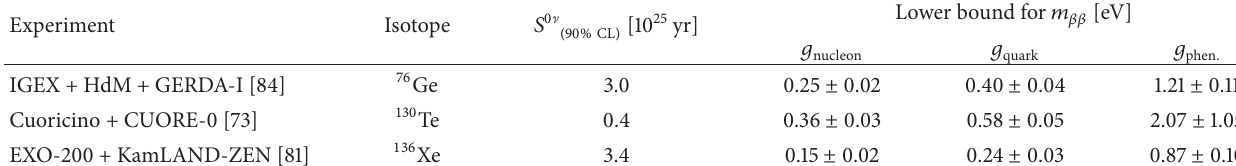
Table 8: Lower bounds for 𝑚 𝛽𝛽 for 76 Ge, 130 Te, and 136 Xe. The sensitivities were obtained by combining the most stringent limits from the experiments studying the isotopes. References [95] and [96] were used for the PSFs and for the NME, respectively. The different results correspond to different values of 𝑔 𝐴 according to (47).